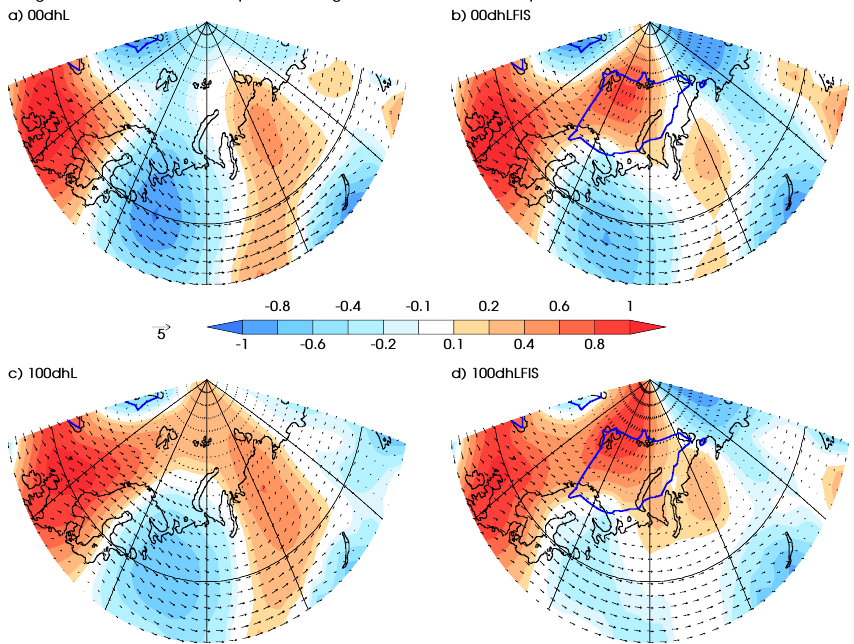
Figure 15. Same as Fig. 14 for the vertically integrated meridional (shaded) and the horizontal heat transport (arrows) in summer. Numerical values are given in 10 10 Jm − 1 s − 1